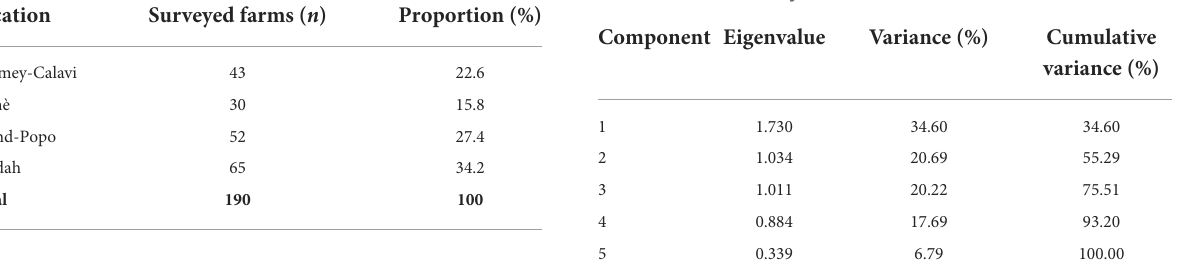
TABLE 2 Distribution of sampled farms across the four municipalities. TABLE 3 Principal components obtained in the factor analysis of mixed data (FAMD)